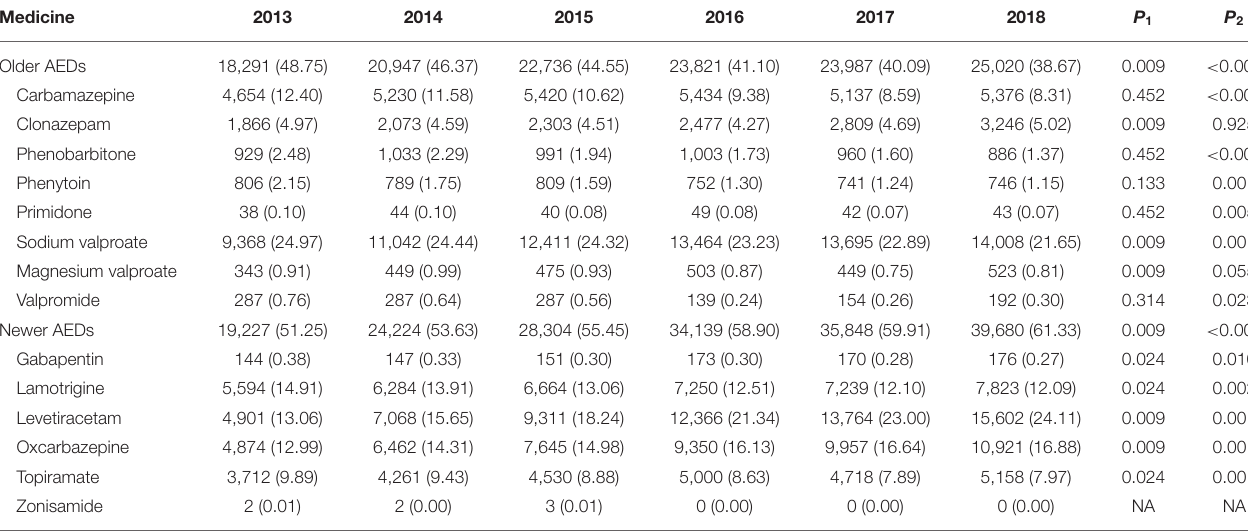
TABLE 2 | Number of anti-seizure medication (ASM) prescriptions from 2013 to 2018.